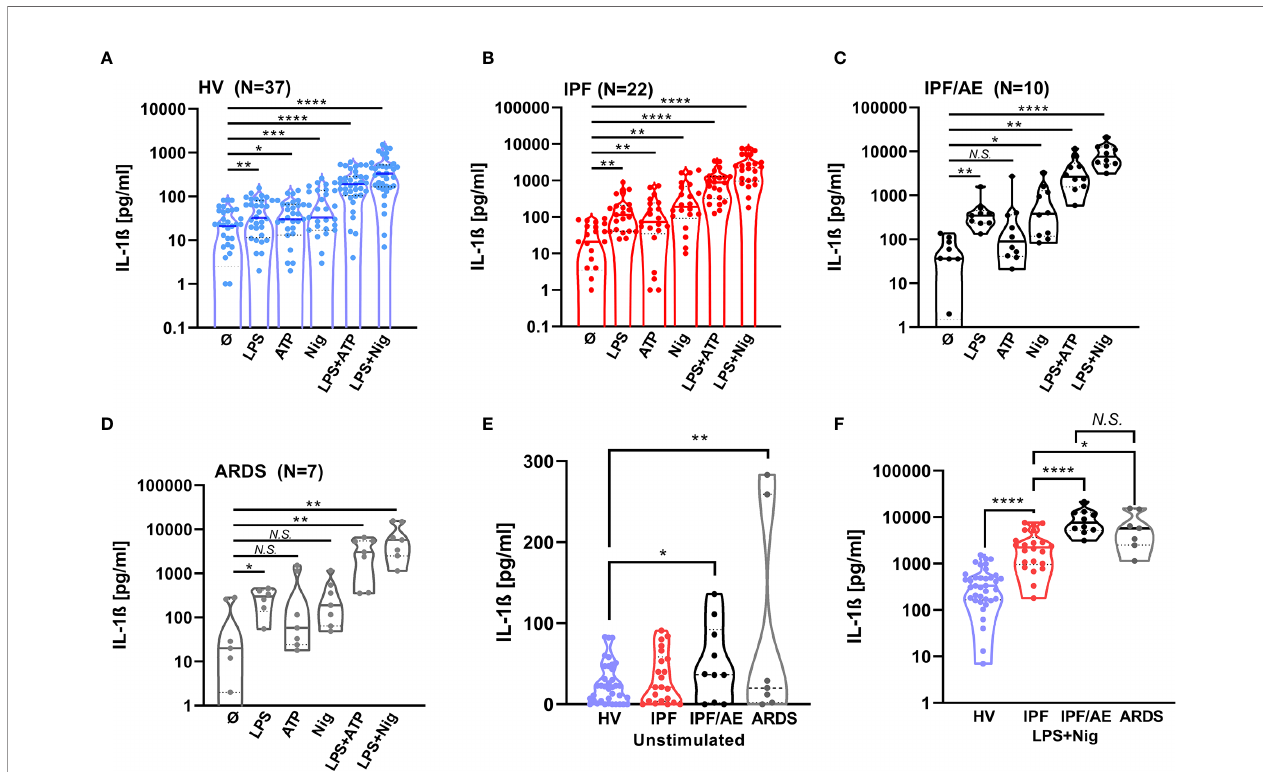
FIGURE 2 | IL-1 b production after NLRP3 in fl ammasome stimulation is highest in BAL cells from patients with an acute exacerbation during IPF and BAL cells from patients with ARDS. IL-1ß production was detected by ELISA and is inducible by NLRP3 stimulation in alveolar macrophages of patients with acute exacerbation of idiopathic pulmonary fi brosis (C) and acute respiratory distress syndrome (D) . IL-1ß values for healthy volunteers (HVs) and IPF are shown for comparison (A, B) . IL-1ß production in these two cohorts is signi fi cantly increased compared to healthy volunteers (HVs) to a similar extent at baseline and following stimulation (E, F) . IL-1ß levels with stimulation compared to baseline and unstimulated IL-1ß levels between groups and LPS/Nigericin stimulation were compared using unpaired t-tests; *p < 0.05; **p < 0.01; *** p < 0.001; ****p < 0.0001, N.S. non-signi fi